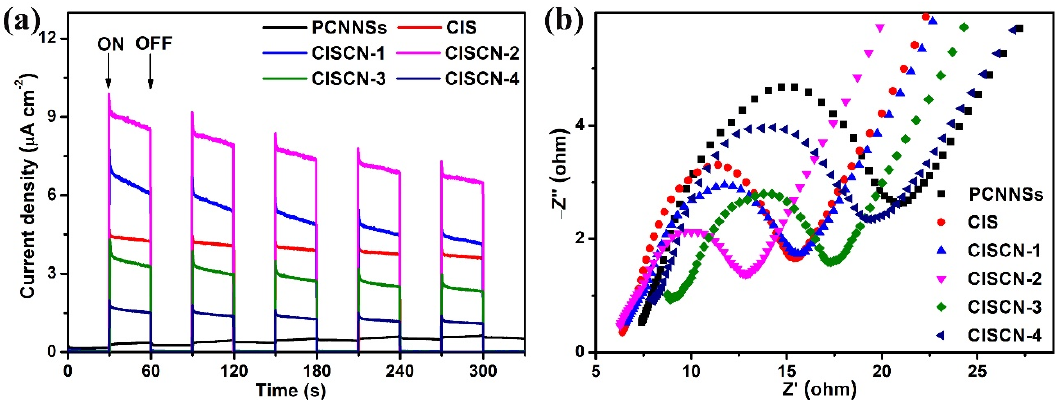
Figure 7. ( a ) Transient photocurrent response plots, and ( b ) EIS of the obtained catalysts.